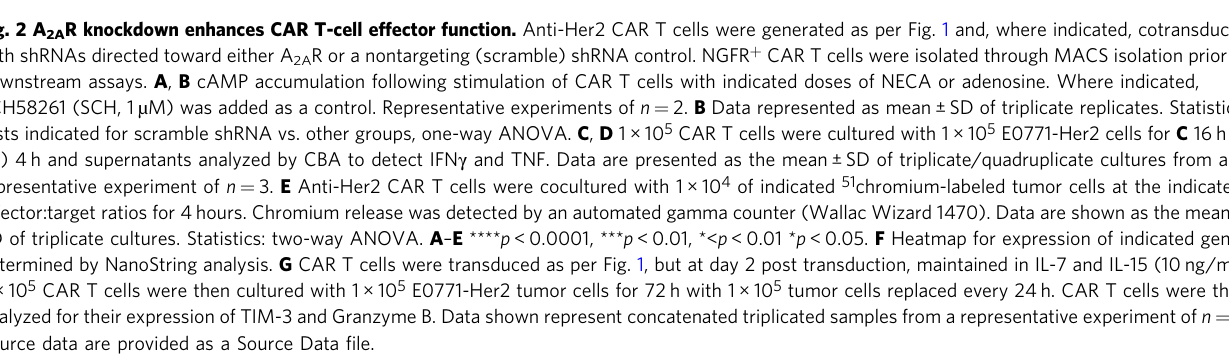
Fig. 2 A 2A R knockdown enhances CAR T-cell effector function. Anti-Her2 CAR T cells were generated as per Fig. 1 and, where indicated, cotransduced with shRNAs directed toward either A 2A R or a nontargeting (scramble) shRNA control. NGFR + CAR T cells were isolated through MACS isolation prior to downstream assays. A , B cAMP accumulation following stimulation of CAR T cells with indicated doses of NECA or adenosine. Where indicated, SCH58261 (SCH, 1 µ M) was added as a control. Representative experiments of n = 2. B Data represented as mean ± SD of triplicate replicates.